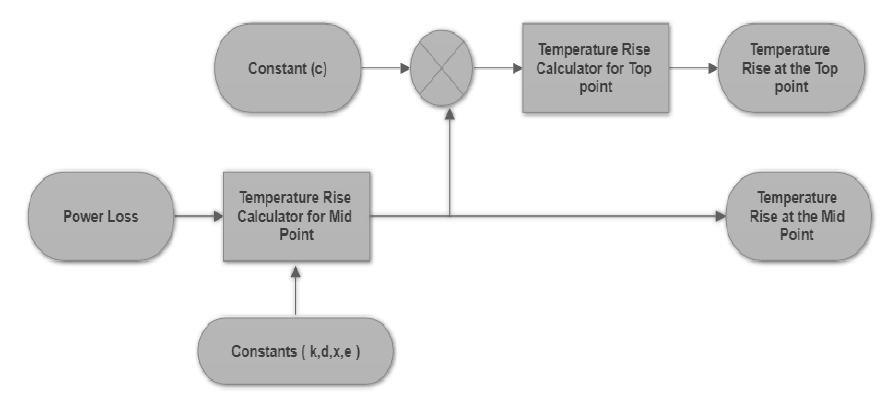
Figure 1: Temperature rise calculation as per IEC TR 60890. Power Loss value and respective enclosure constants should be provided as inputs.